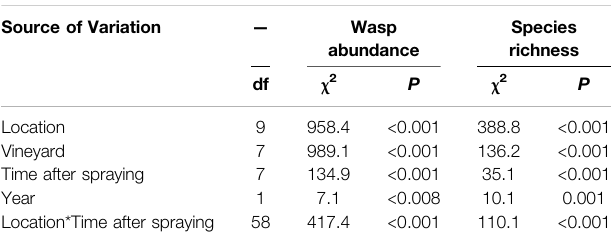
TABLE 1 | Results of generalized linear model of factors affecting wasp abundance and species richness. Source of